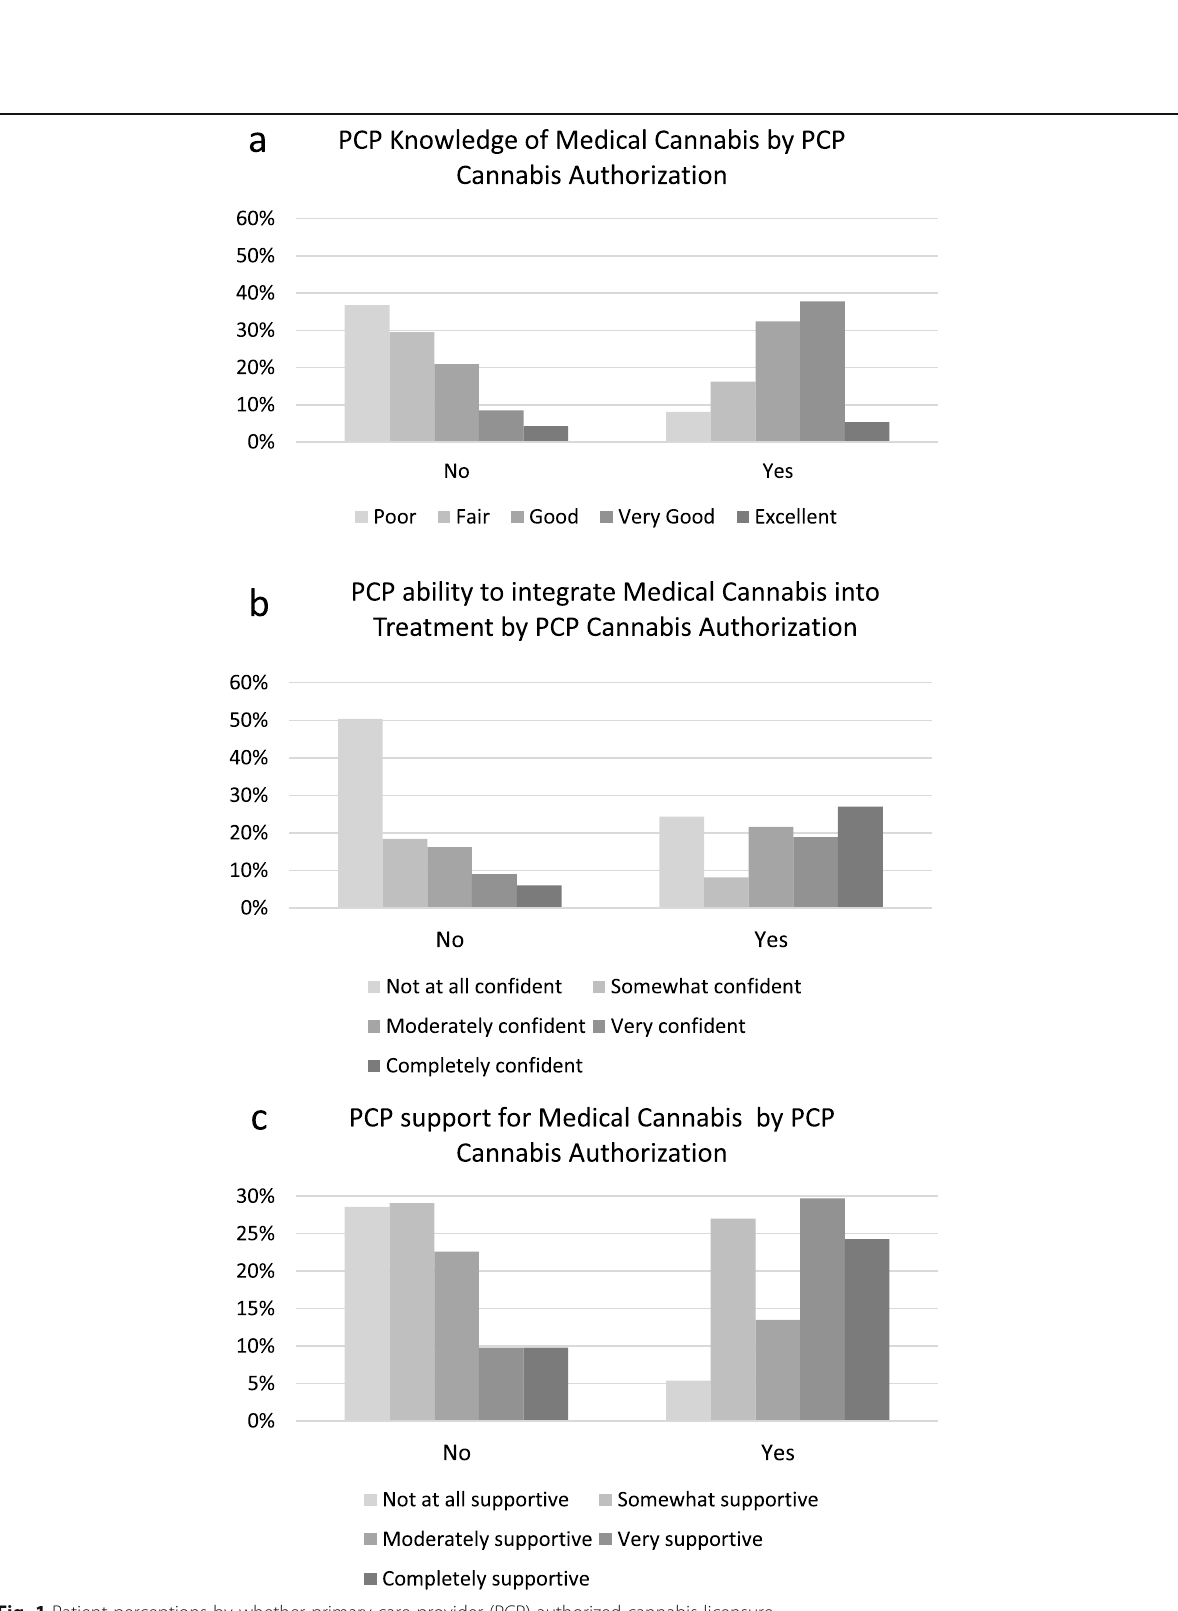
Fig. 1 Patient perceptions by whether primary care provider (PCP) authorized cannabis